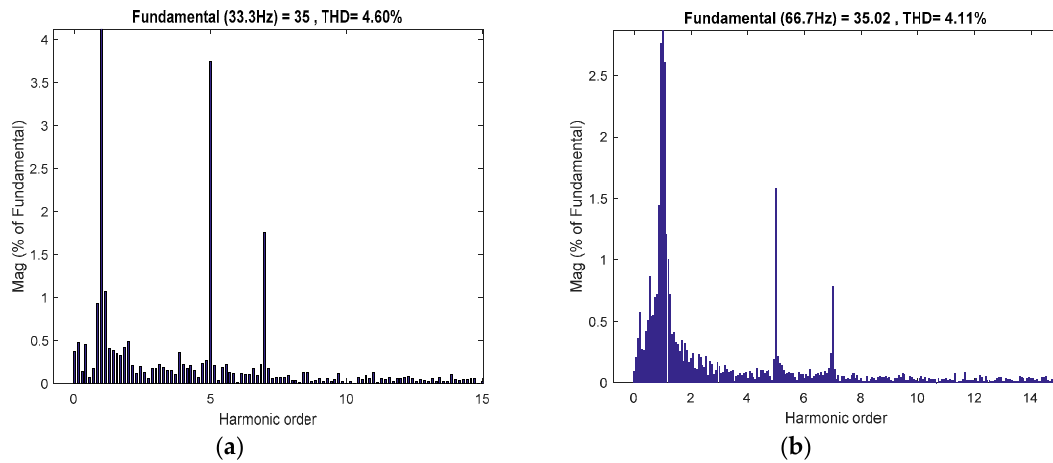
Figure 16. THDs of the phase A current after adopting the proposed feedforward voltage compensation method only, ( a ) speed is maintained at 500 rpm, and ( b ) speed is maintained at 1000 rpm.